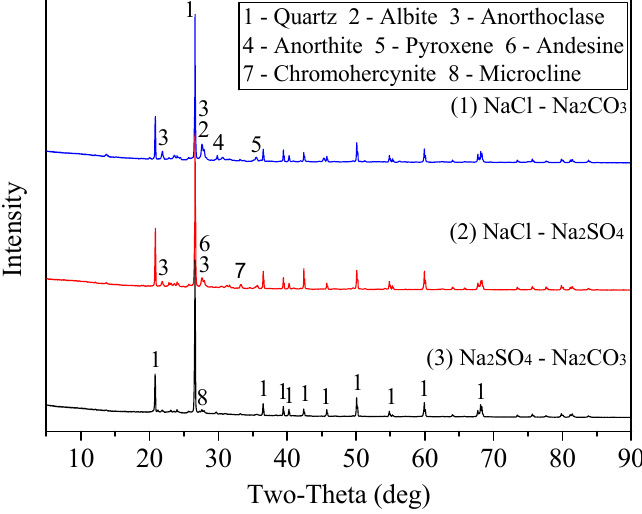
Figure 7. The XRD pattern of leaching residues added with a composite additive.